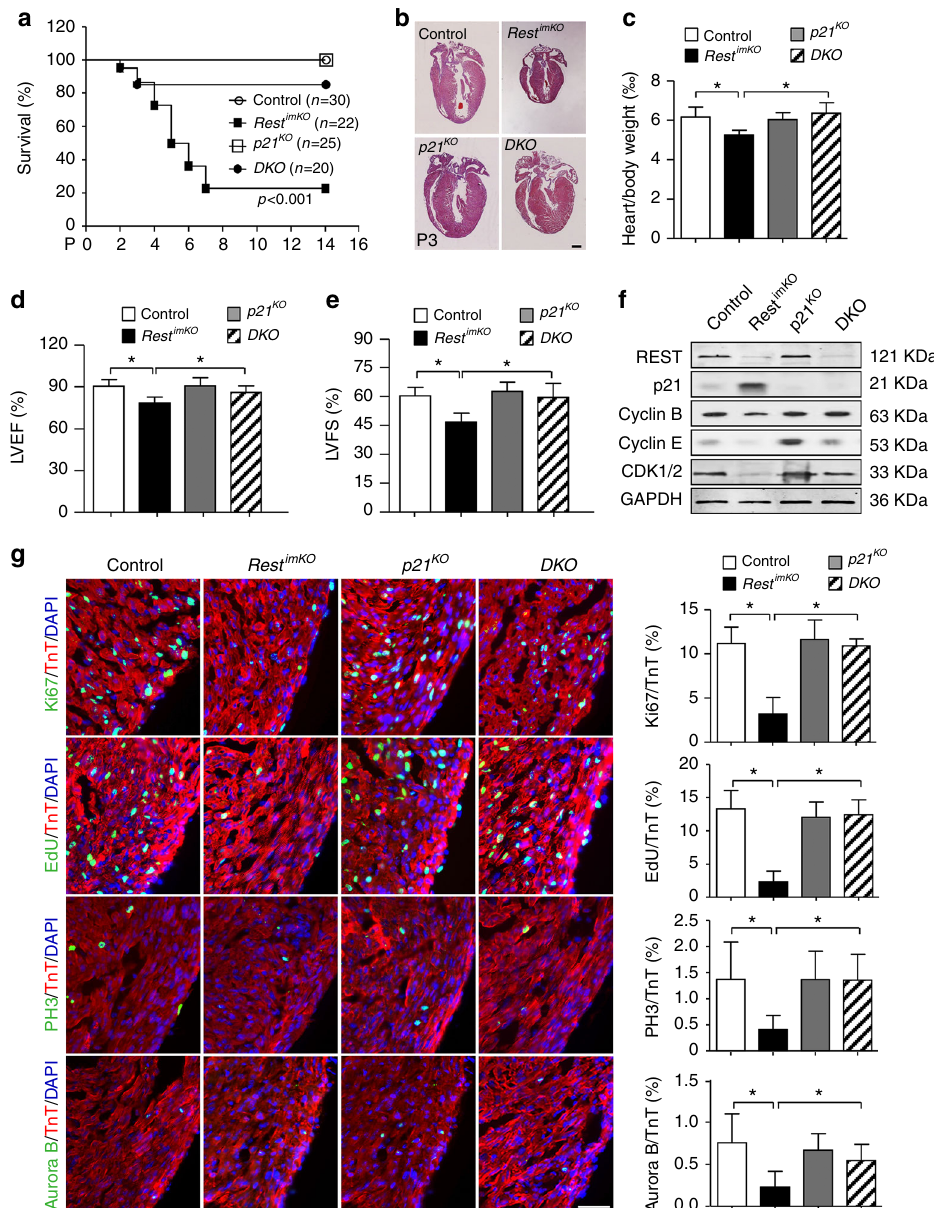
Fig. 5 p21 deletion rescues neonatal heart defects resulting from Rest deletion. a Survival curve, no difference between control and p21 null ( p21 KO ) or p21/ Rest double knockout ( DKO ) group by log-rank (Mantel – Cox) test. p < 0.001 between Rest imKO and each of other groups. b , c H&E-stained P3 heart sections showing that underdeveloped Rest null hearts are restored by p21 deletion ( n = 5/group). Scale bar = 100 μ m. d , e Echocardiograph showing p21 knockout rescues cardiac function resulting from Rest deletion at P1 ( n = 6 – 8/group). f Representative western blot revealing upregulation of p21 and downregulation of Cyclin B, Cyclin E, and CDK1/2 in P3 Rest null hearts are restored by p21 deletion to the normal levels of control hearts. g Immunostaining for cell cycle markers indicating p21 inactivation rescues the cell cycle defect resulting from Rest deletion ( n = 4/group). Scale bar = 40 μ m. Controls were the Tam-treated Rest +/+ ; TnT MerCreMer/ + mice. Mean ± s.d. * p < 0.05 by one-way ANOVA followed by Tukey ’ s gene signi fi cantly upregulated in Rest null hearts, whereas the expression of several cell cycle activators was downregulated (Supplementary Fig. 5a). These fi ndings were then con fi rmed by qRT-PCR (Supplementary Fig. 5b, c). Notably, p21 was also the only cell cycle inhibitor gene which expression was signi fi cantly upregulated in P2 ventricles with myocardial Rest inactivation at P1 (Supplementary Fig. 5d). Immunostaining further showed an increased number of p21 -expressing cardiomyocytes in E12.5 and P3 Rest null hearts (Fig. 3a, b). We identi fi ed one conserved REST-binding site (RE1 motif) located at the 3 ′ end of mouse p21 gene by sequence alignment between mouse and human (Fig. 3c).